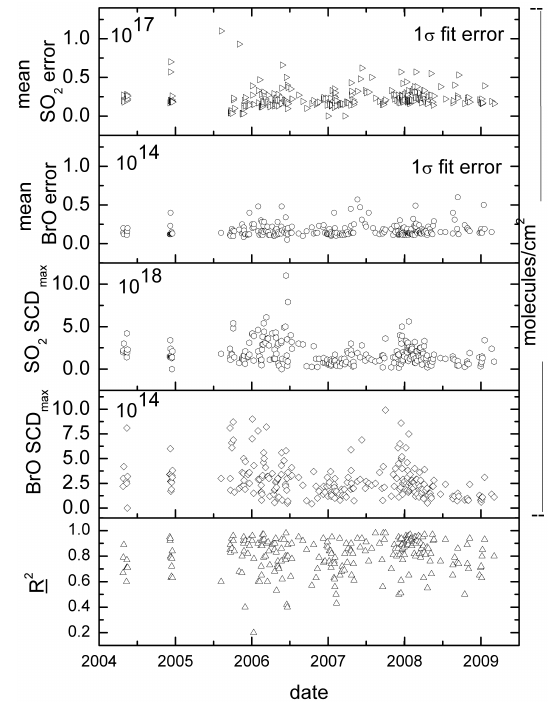
Fig. 2b. For each data point of (a) , the adjusted R 2 , the maximum BrO and SO 2 SCD of each measurement day as well as a mean one sigma fit error for SO 2 and BrO are shown as a function of